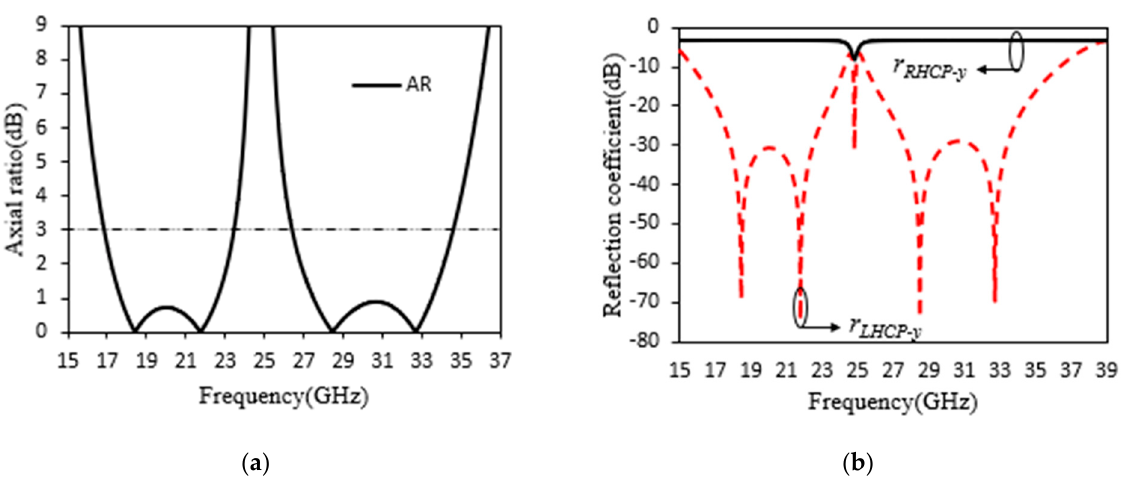
Figure 3. The calculated results of the proposed rectangular-slot converter under y -polarized inci- dence. ( a ) Axial ratio (dB) and ( b ) r RHCP − y and r LHCP − y